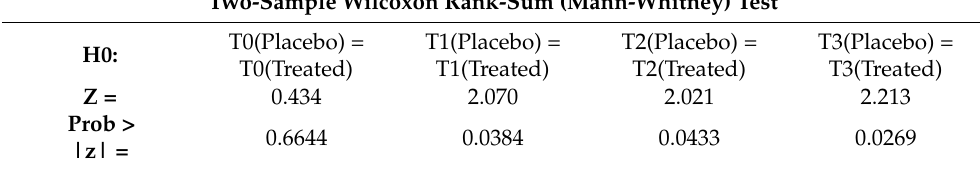
Table 2. Test results, non-parametric for independent samples, of the sum of the ranks of Wilcoxon and Mann-Whitney. Comparison between treated and placebo groups over time. No significant statistical difference between Treated and Placebo at T0 ( p > 0.6644). Statical significance appeared at both T1 ( p = 0.0384) and T2 ( p = 0.0433), and greatly increase at T3 ( p = 0.0269).